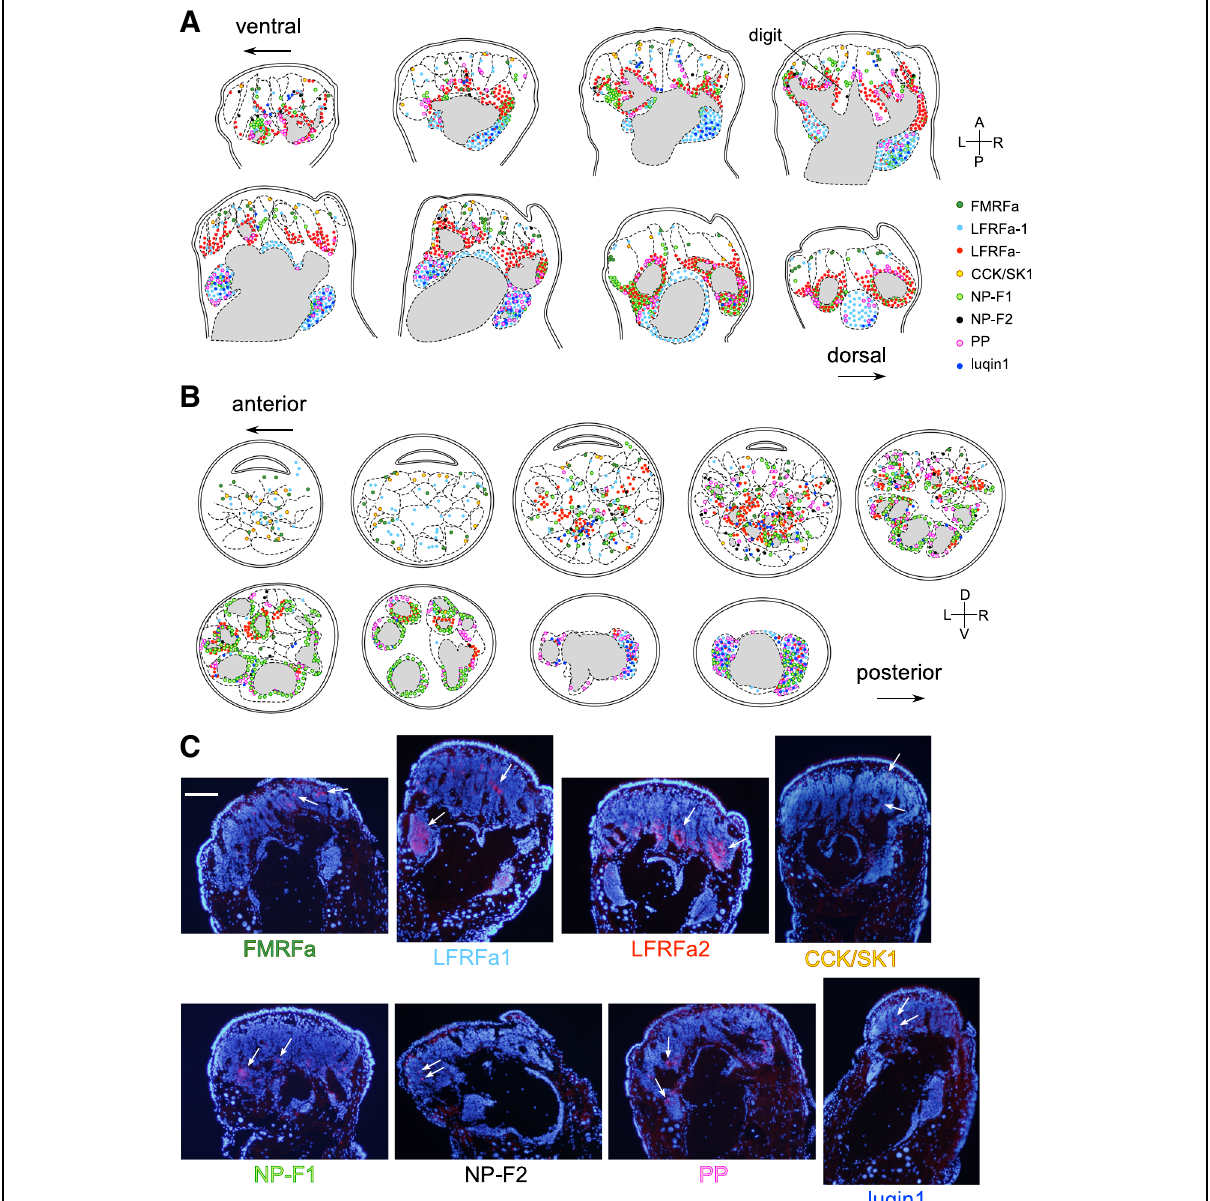
Fig. 5 Expression maps of eight RFamide genes in the IT. Schemata showing the distribution of the neurons expressing RFamide genes in ( a ) horizontal and ( b ) coronal sections. c Examples of images of in situ hybridization in horizontal sections of the left IT. Positive signals are in red, and nuclei are in blue. White arrows indicate some of the positive signals. For the direction of the sectioning, see the cartoon in Fig. 4. Scale bars: 100 μ m (applicable to all photographs). D, dorsal; V, ventral; A, anterior; P, posterior; R, right; L,